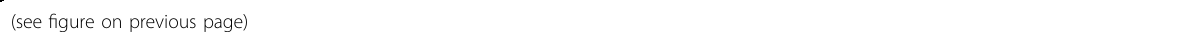
Fig. 2 Lnc-LALC was upregulated in CRC cells and positively correlated with metastatic factors. A The top 15 dysregulated lncRNAs in TanyNanyM1 group were shown by hierarchical clustering analysis. B The top 15 dysregulated lncRNAs in TanyN + M0 group were shown by hierarchical clustering analysis. C The top 15 dysregulated lncRNAs in TanyN0M0 group were shown by hierarchical clustering analysis. D VENNY analysis identi fi ed 4 lncRNAs which were all aberrantly regulated in the three comparisons (TanyNanyM1, TanyN + M0, and TanyN0M0). E Relative expression of LINC00922 in the above 40 tissues was assessed by qRT-PCR. N group was used as a control. F A negative correlation between expression levels of Lnc-LALC and LZTS1 in tissues was determined by Person analysis ( n = 40, r = − 0.6213, P < 0.0001). *** P < 0.001; ** P < 0.01 and * P < 0.05. G The LINC00922 expression patterns in CRC cell lines and NCM460 cell lines were assessed by qRT-PCR. H Cellular characterization of lnc- LALC in SW480 cells, the levels of nuclear control transcript (U6), cytoplasmic control transcript (glyceraldehyde-3-phosphate